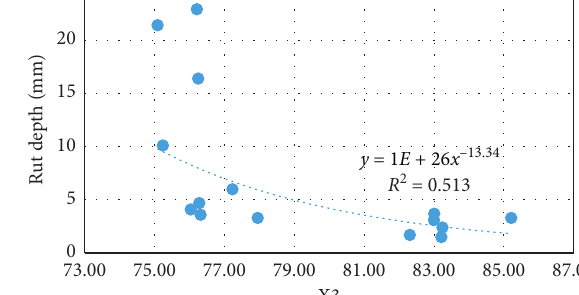
Figure 3: Correlation between PG